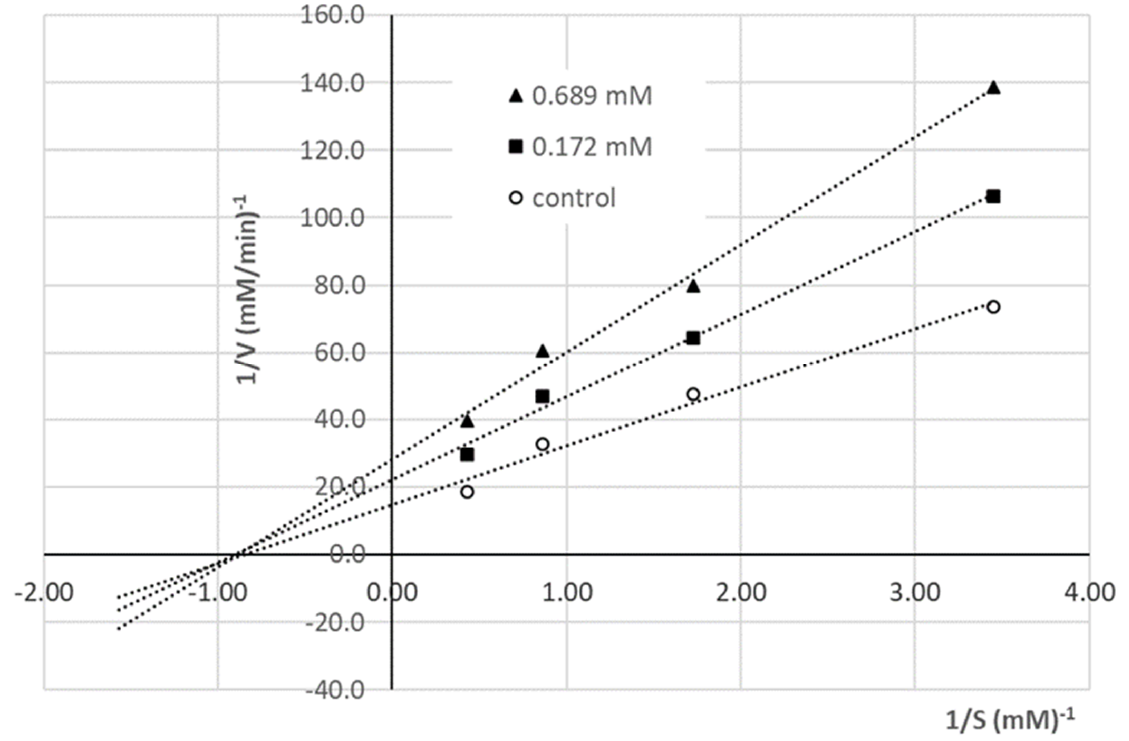
Figure 3. Lineweaver–Burk plots of ACE activity in the presence of NDRP at concentrations of 0.689 mM ( ▲ ) and 0.172 mM ( ■ ) and without the inhibitory peptide ( ○ , control); HHL was used as the enzyme substrate. All experiments were conducted in triplicate.